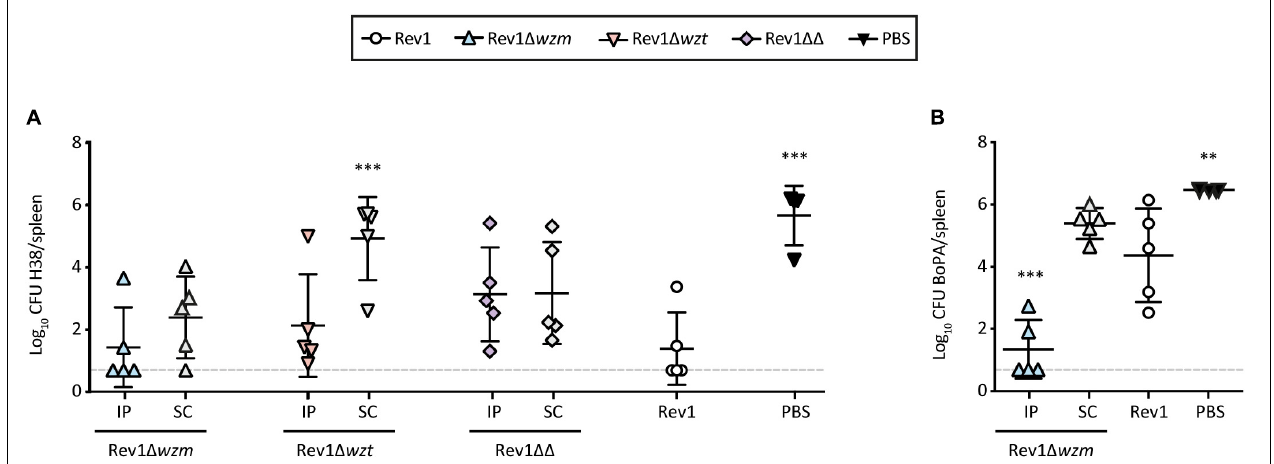
FIGURE 6 | Rev1 (cid:49) wzm protects against virulent B. melitensis and B. ovis challenges in the BALB/c mice. Efficacy in the BALB/c mice ( n = 5) IP or SC vaccinated with Rev1 wzm / wzt mutants (10 8 CFU/animal) or with Rev1 reference vaccine (10 5 CFU/animal, SC) or PBS as controls; after 4 weeks, the mice were IP challenged with (A) 1 × 10 4 of B. melitensis H38:Gm r (H38) or (B) 5 × 10 5 of B. ovis PA:Gm r (BoPA:Gm r ). After 2 or 3 weeks, respectively, the mean ± SD ( n = 5) log 10 CFU of the challenge strain in spleens was determined. Detection limit (log 10 5 CFU/spleen = 0.70) is indicated with a discontinuous line. Fisher’s LSD test; ∗∗∗ p ≤ 0.001, ∗∗ p ≤ 0.01 vs. Rev1